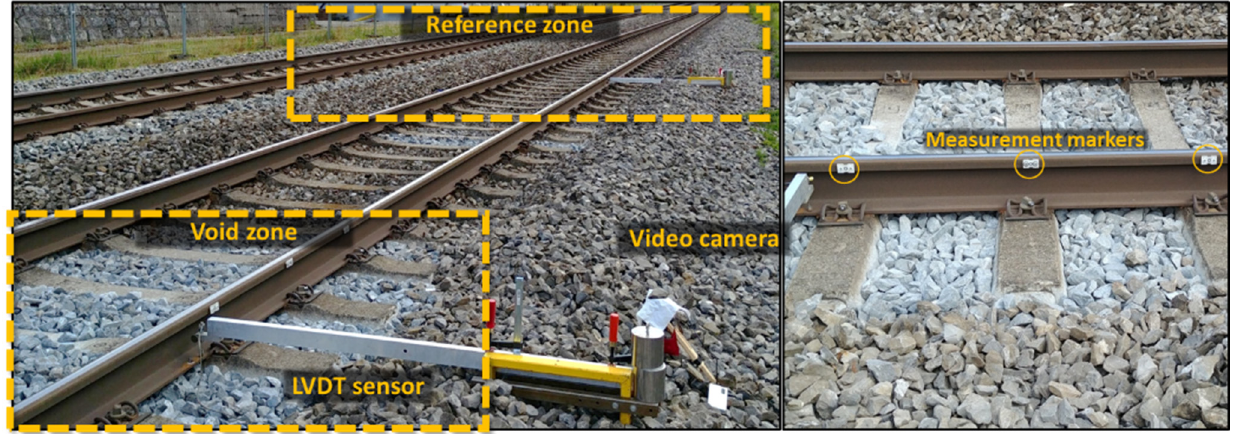
Figure 12. Experiment set-up for rail deflection measurement.